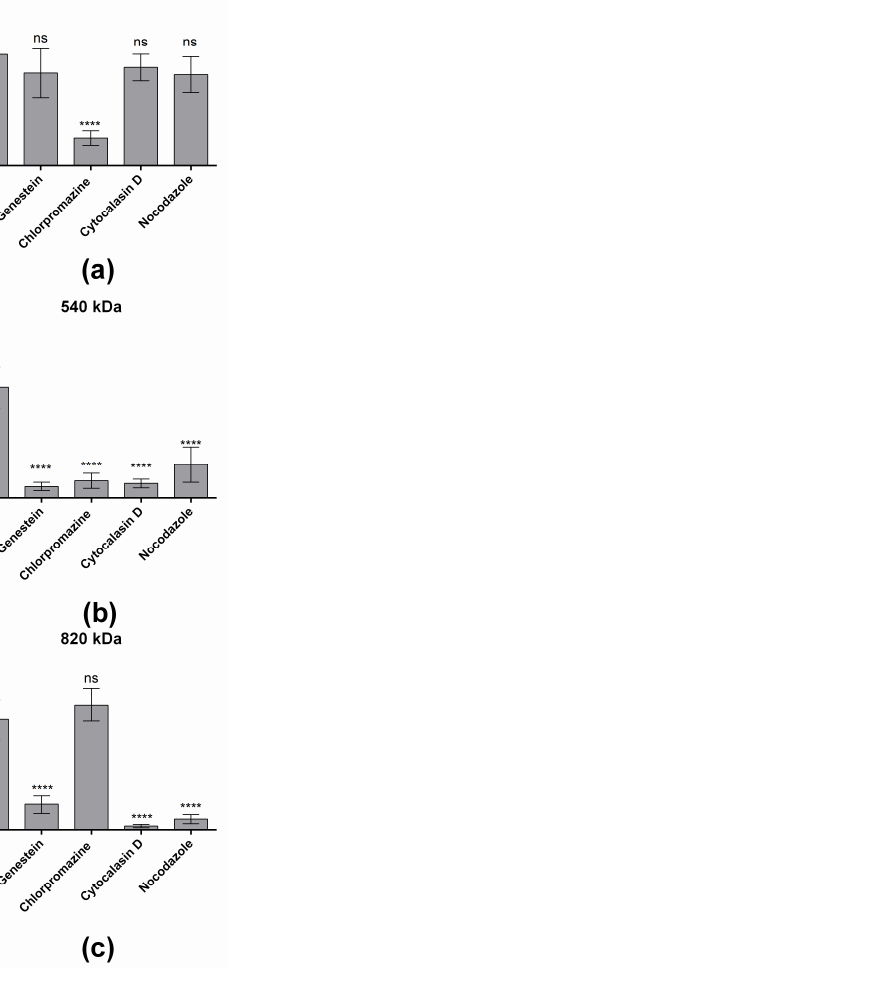
Figure 7. Effect of transport inhibitors on the internalization of HA/CS-RhB NPs made of ( a ) 280 kDa, ( b ) 540 kDa and ( c ) 820 kDa HA. Results are expressed as CTCF percentage mean ± SD. ns p value > 0.05; **** p value < 0.0001.